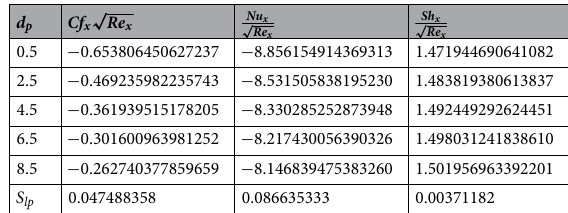
0.1 and D 100 , S r = ∞ =